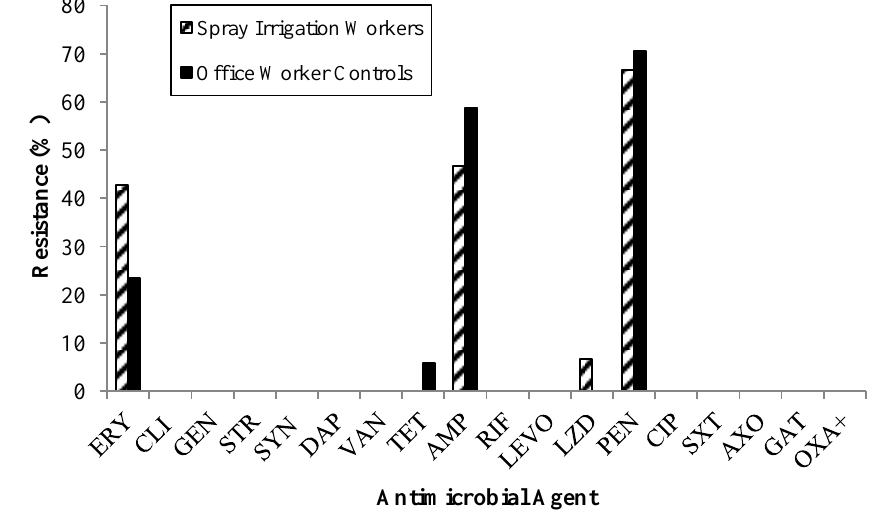
Figure 2. Percent resistance to antimicrobial agents observed among MSSA isolates recovered from spray irrigation worker and office worker control nasal and dermal